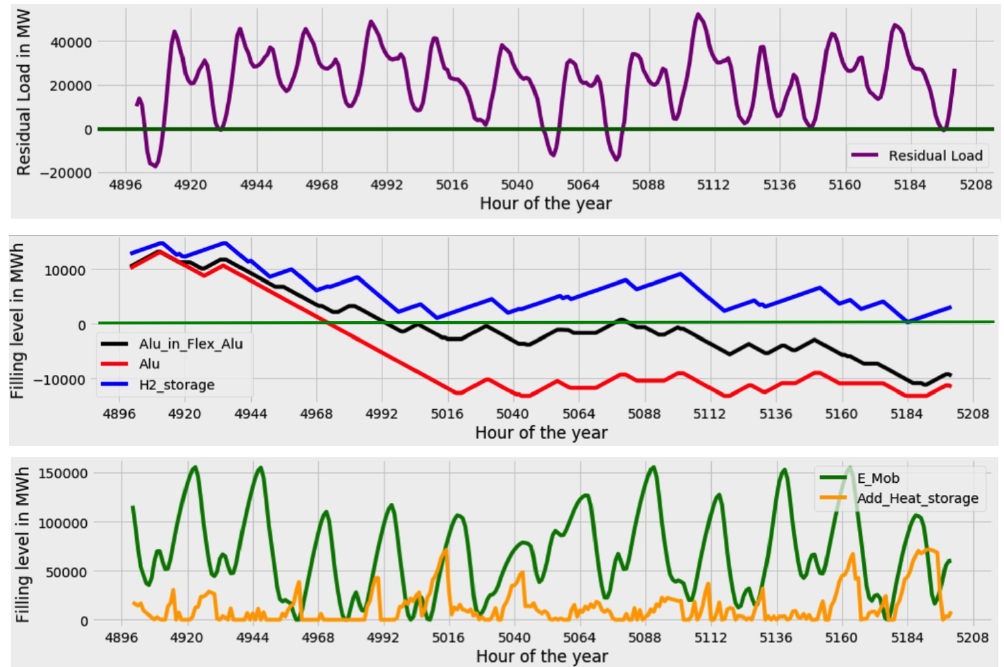
Figure 8. Residual load and storage levels in hours 4900 to 5200 of the year